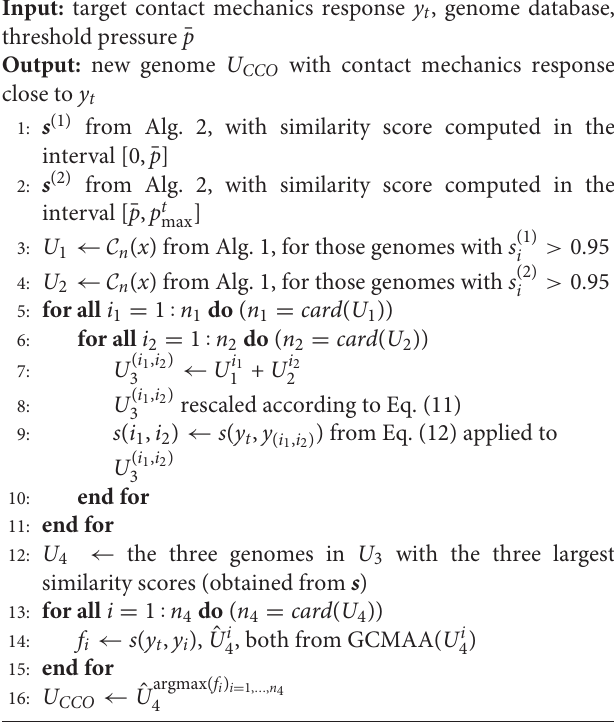
Algorithm 5 | Chromosomes Cross-Over